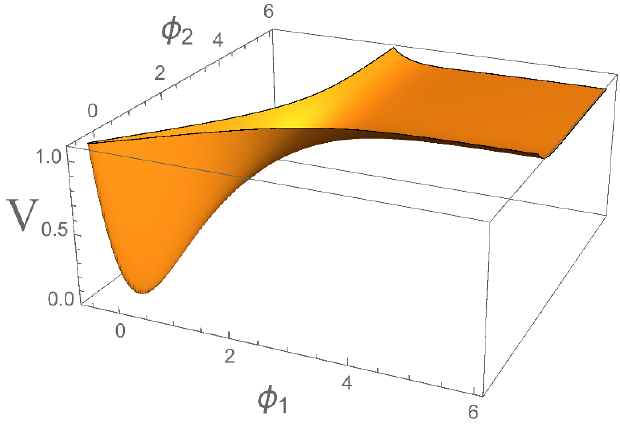
Figure 4 . Merger of two disks with (cid:11) = 1 = 3 creates the in(cid:13)aton potential with (cid:11) = 2 = 3. Here we considered an example with M = 6 m